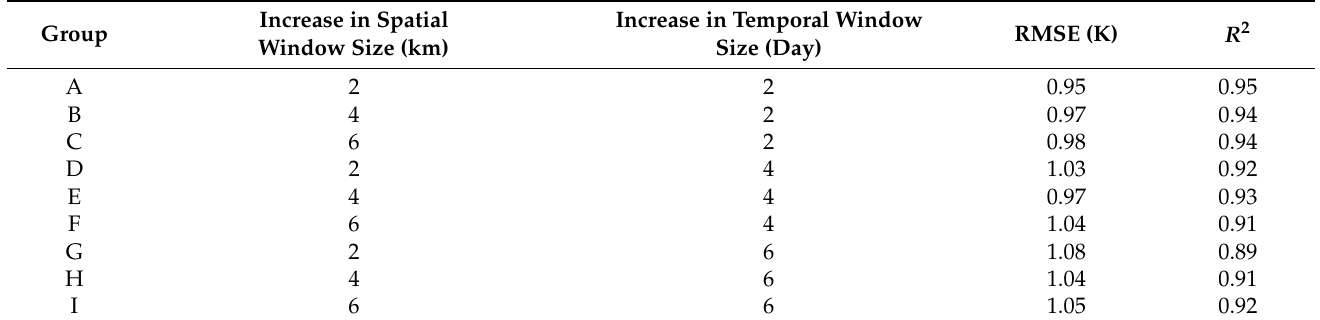
Table A1. The performance of the ATC_GL according to different combinations of increased size in spatial and temporal windows, respectively.